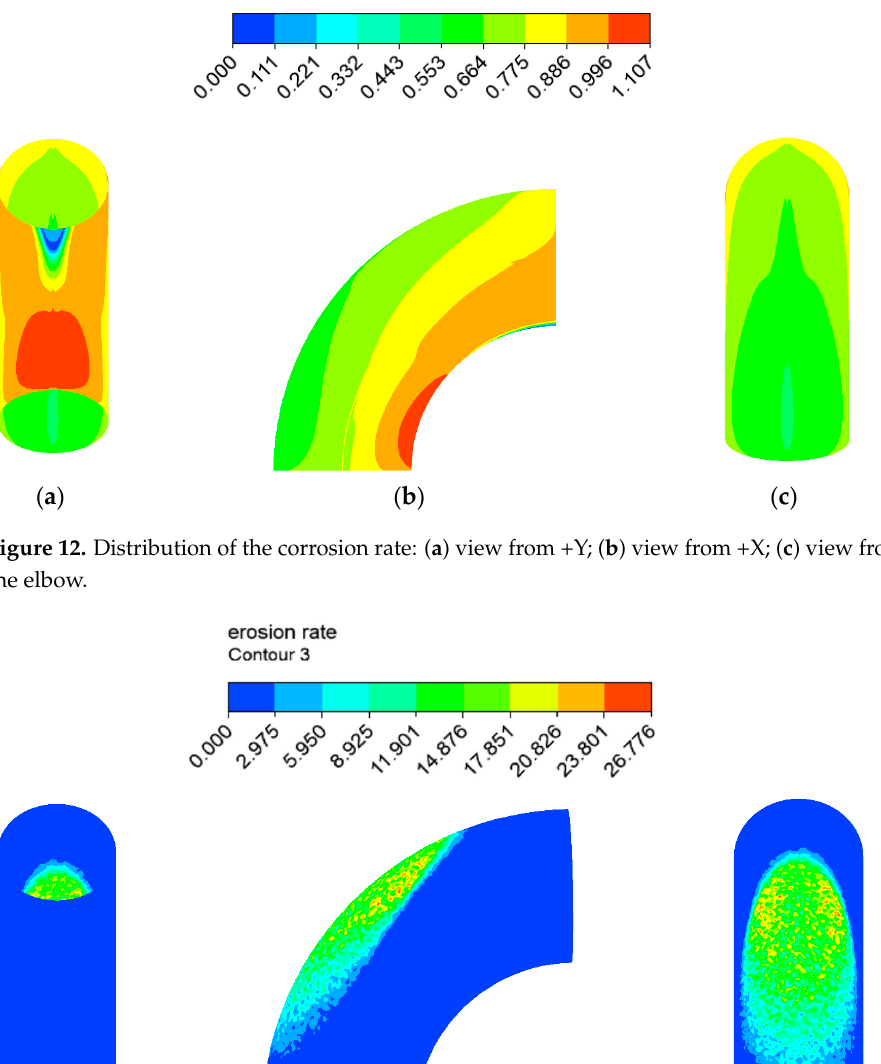
Figure 11. Distribution of the volume fraction of the liquid phase.